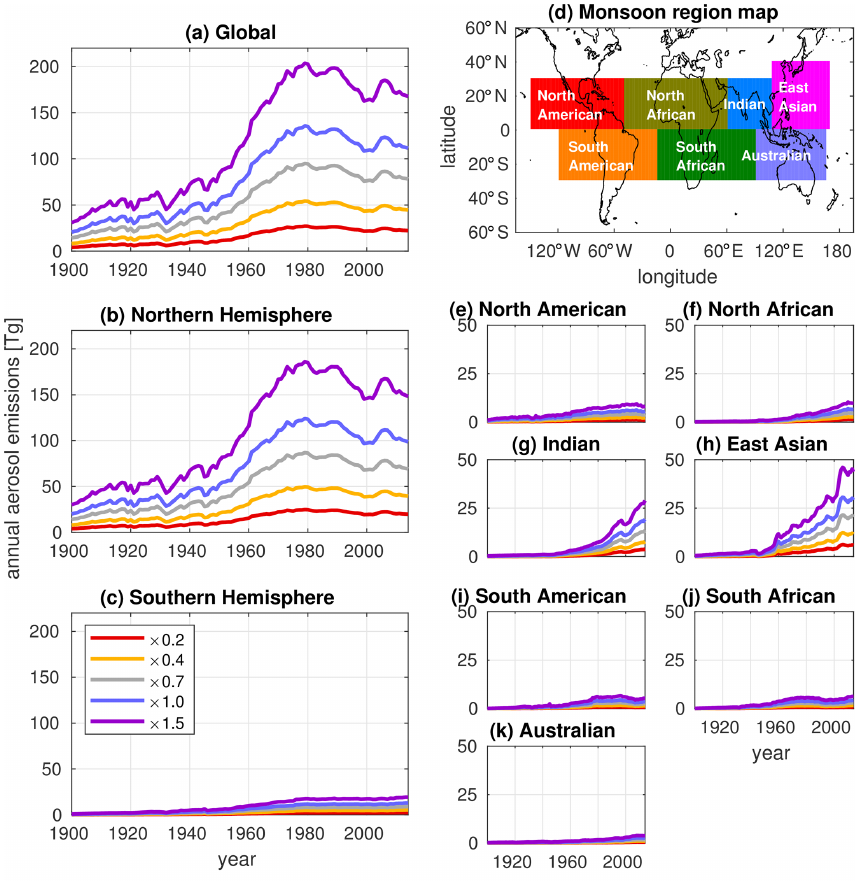
Figure 1. Sulfur dioxide emissions used in SMURPHS on (a) global, (b, c) hemispheric and (e–k) regional scales, in Tgyr − 1 . Organic and black carbon emissions are scaled in the same way. Monsoon regions referred to in this study are as defined in (d)